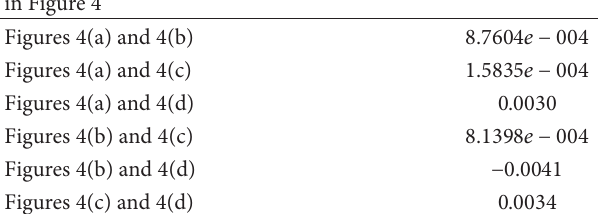
Table 3: Correlation between various decrypted images shown in Figure